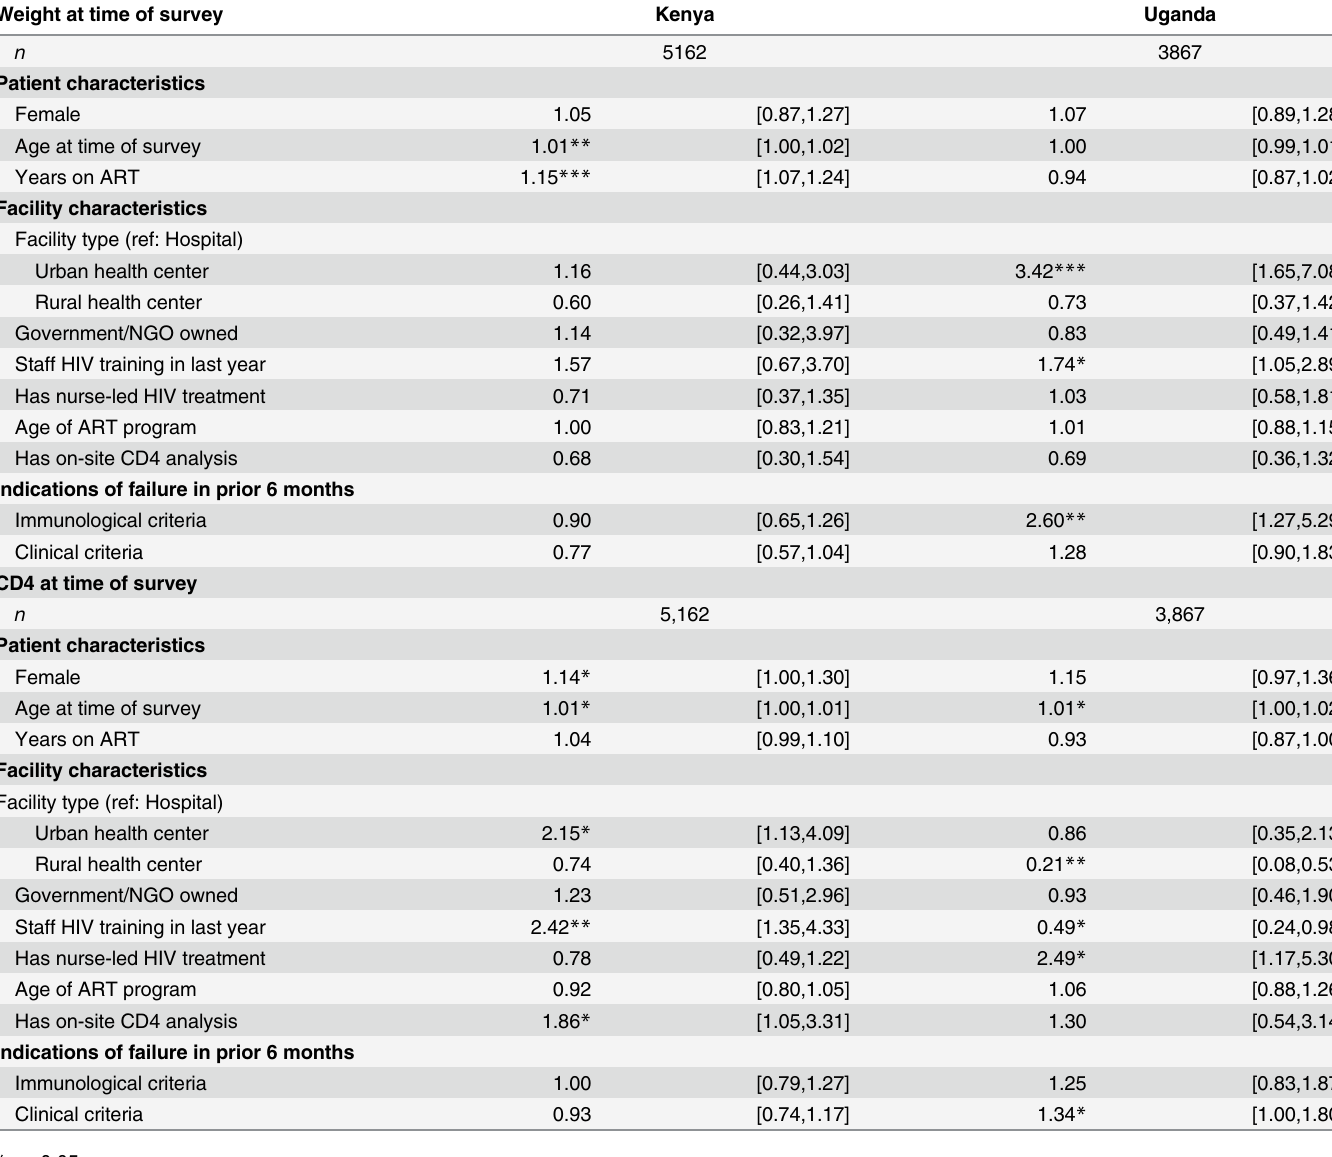
Table 3. Predictors of meeting CD4 and weight monitoring guidelines: mixed effects logistic regression results for established patients in care at the time of the survey. Weight at time of